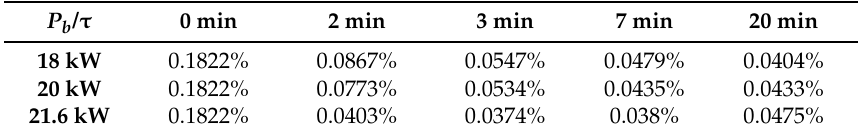
Table 2. Concentration of impurities depending on the beam power and refining time of the EBM of Ta. P b /